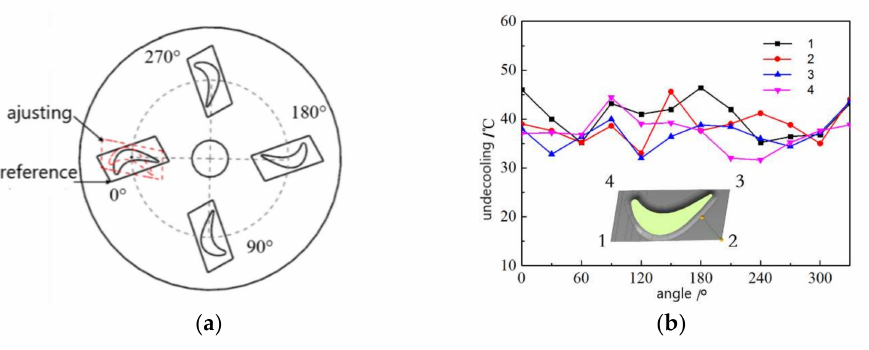
Figure 12. ( a ) Schematic diagram of mold assembly; ( b ) Change of undercooling degree at position 1, 2, 3,